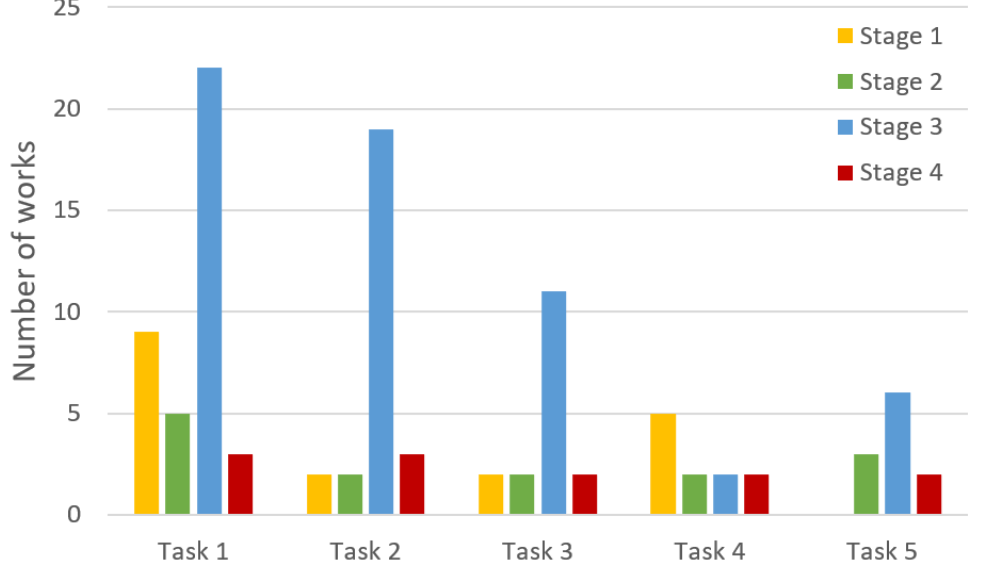
Figure 5. Histogram of research work distribution for static analysis and machine-learning